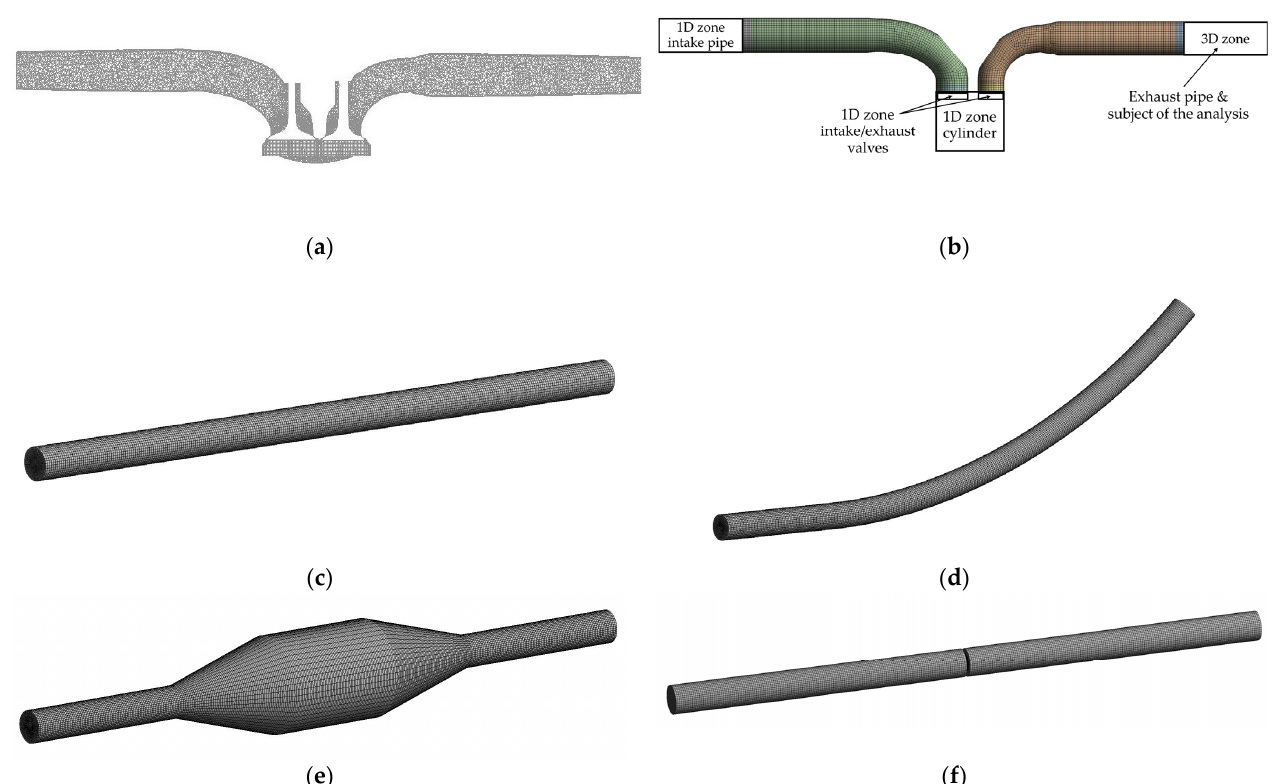
Figure A1. The mesh modeling for numerical analysis using 3D and 1D–3D approach: ( a ) 3D approach; ( b ) intake/exhaust port of the 1D–3D approach; ( c ) straight pipe; ( d ) bent pipe; ( e ) tapered pipe; ( f ) an orifice installed in the center of the